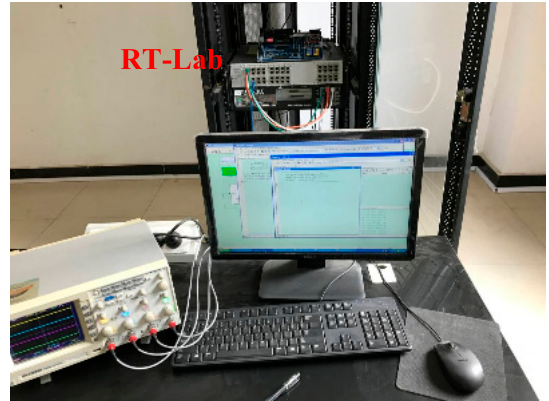
Figure 8. RT-Lab HILS experiment setup.